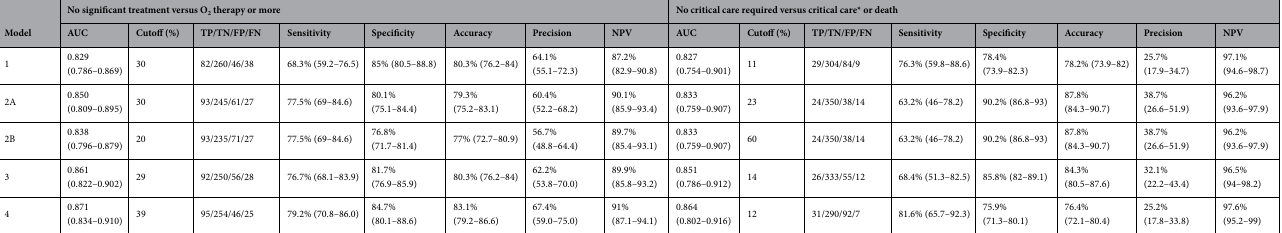
Table 3. Model performance in early prediction of prognosis in COVID19 patients in the external validation cohort. Values in parentheses are 95% confidence intervals. AUC area under the receiver